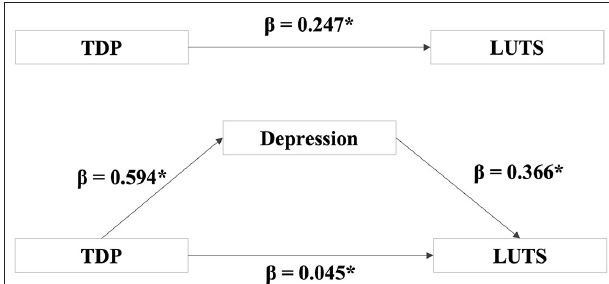
FIGURE 1 | Depression partially mediated the relationship between TDP and LUTS. After controlling for depression, it was observed that the direct effect between TDP on LUTS was still statistically significant ( β = 0.045, P = 0.01) but less than the direct effect without controlling depression ( β = 0.247, P < 0.00). β = the regressive parameter estimate. * P <